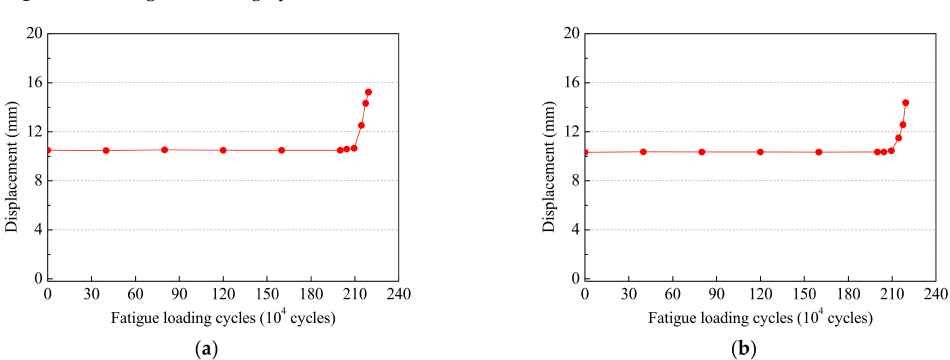
Figure 10. Fatigue loading cycles-strain curves: ( a ) XL3; and ( b ) XR3.